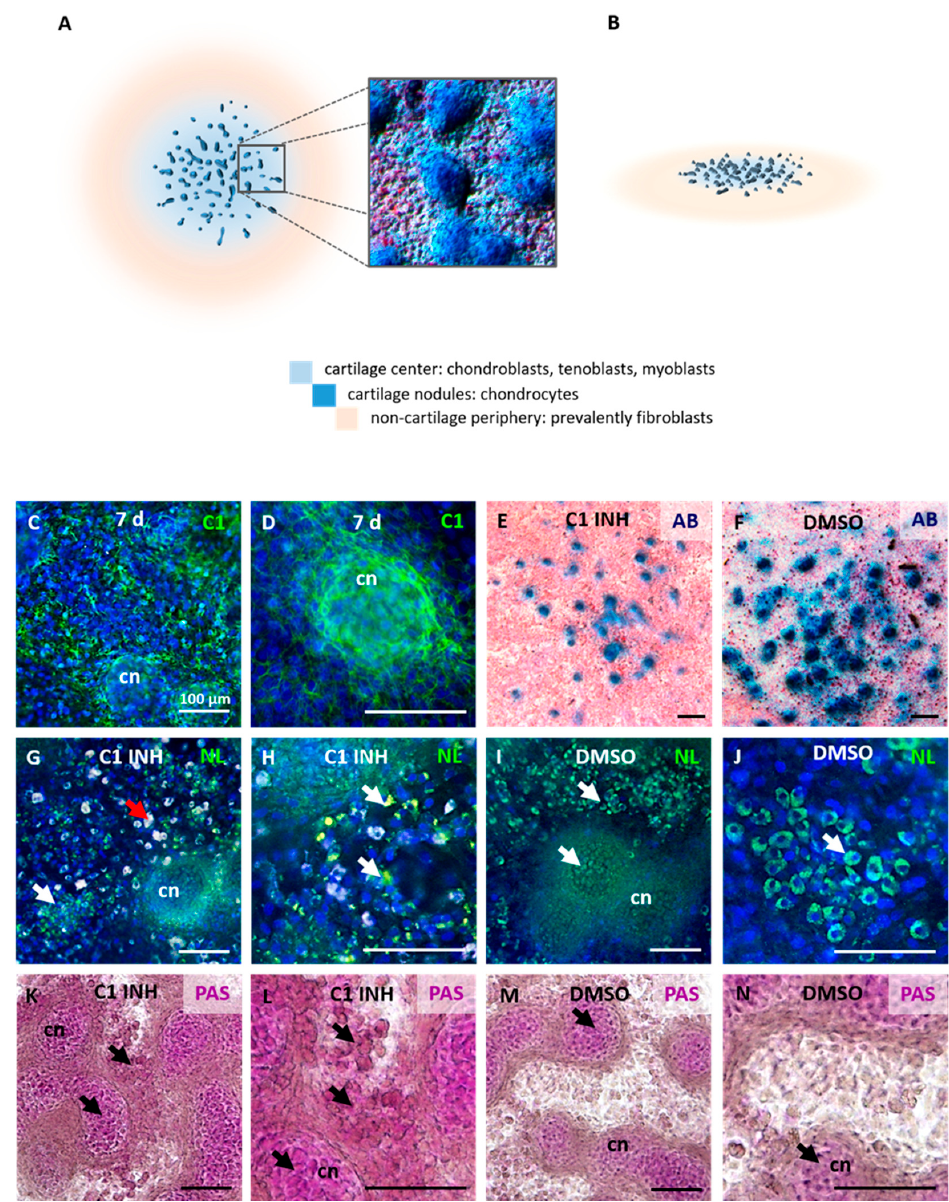
Figure 2. Characterization of micromass cultures treated by caspase-1 inhibitor. Scheme of micromass cultures ( A , B ), showing the arrangement of chondrogenic and non-chondrogenic cells in the culture. Activation of caspase-1 in the micromass cultures ( C ), predominantly in the highly differentiated central part containing chondrogenic nodules ( D ). Alcian blue (cartilage extracellular matrix)/eosin staining of caspase-1 inhibited ( E ) and control ( F ) micromass cultures. Lipid accumulation in cultures with inhibited caspase-1 ( G , H ) and control cultures ( I , J ). PAS staining was performed on caspase-1 treated ( K , L ) and control samples ( M , N ). The white arrows point to lipid accumulation, the red arrow to polysaccharide accumulation, and the black arrows to positive PAS staining. cn (cartilage nodule), AB (alcian blue), NL (neutral lipid stain), PAS (Periodic acid–Schiff). Scale bar = 100 µ